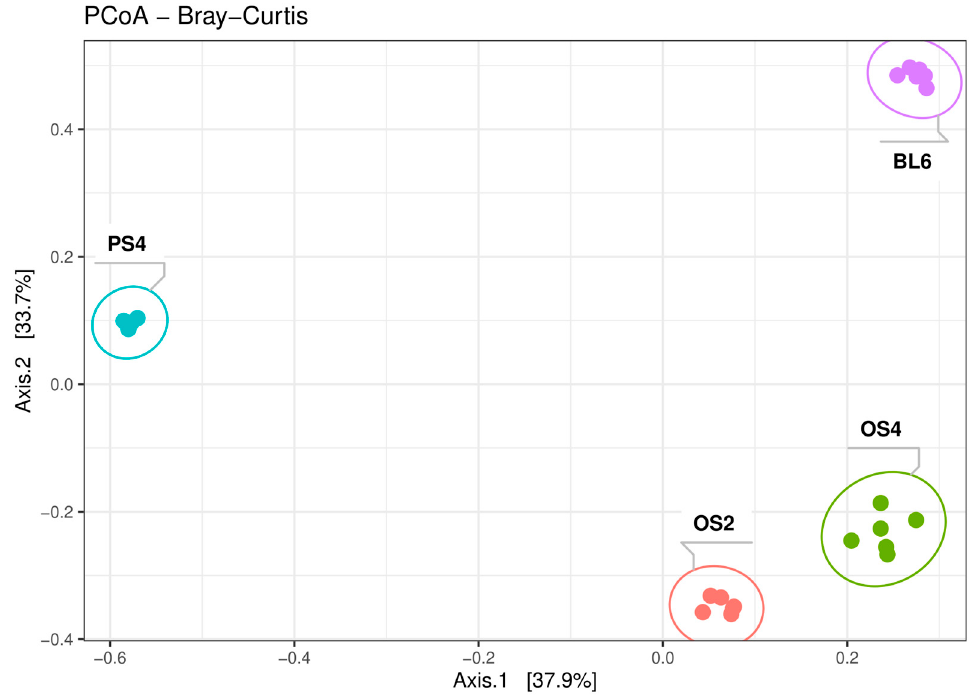
Figure 3. PCoA plot of the beta-diversity of the four cellulolytic consortia (OS2, OS4, PS4, BL6) ac- cessed with Bray–Curtis, based on 16S rRNA gene amplicon